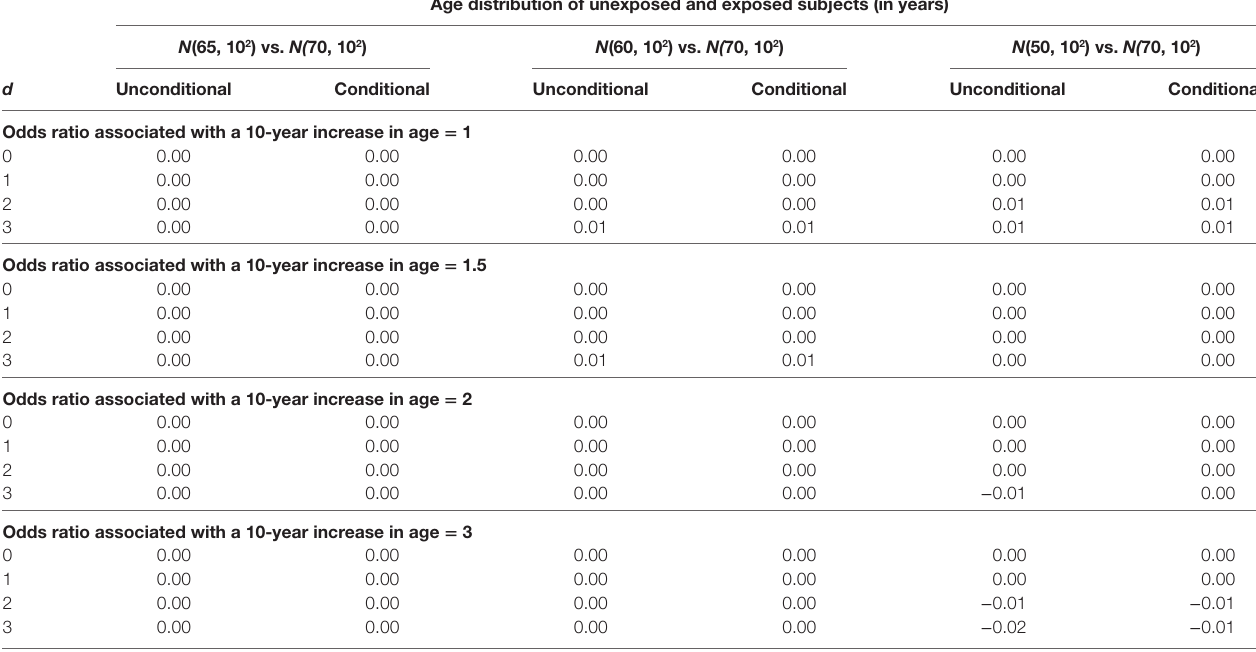
Table 3 | Biases of unconditional and conditional logistic regression models under the null